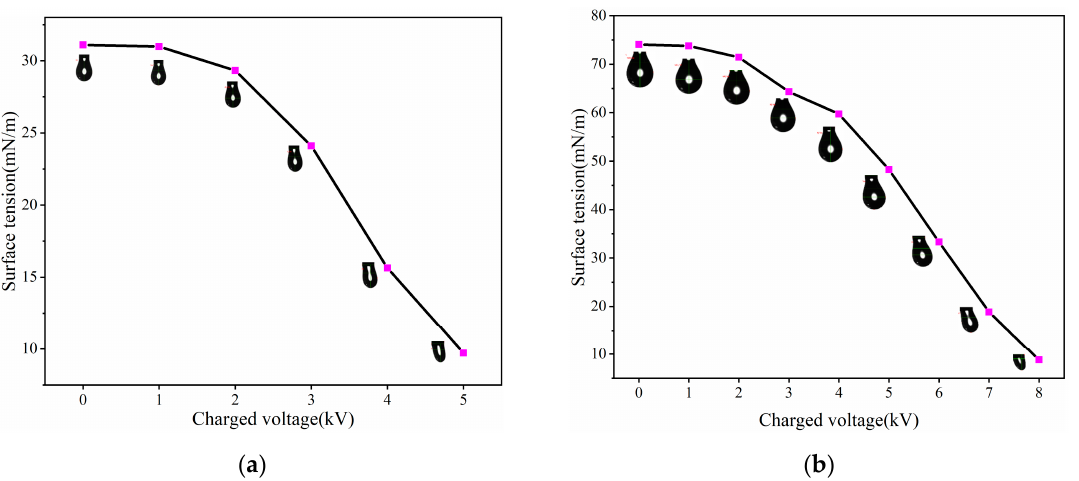
Figure 10. The surface tensions and shapes of droplets under di ff erent charged voltages: ( a ) 0.02% AEO-9-charged; ( b ) water-charged.